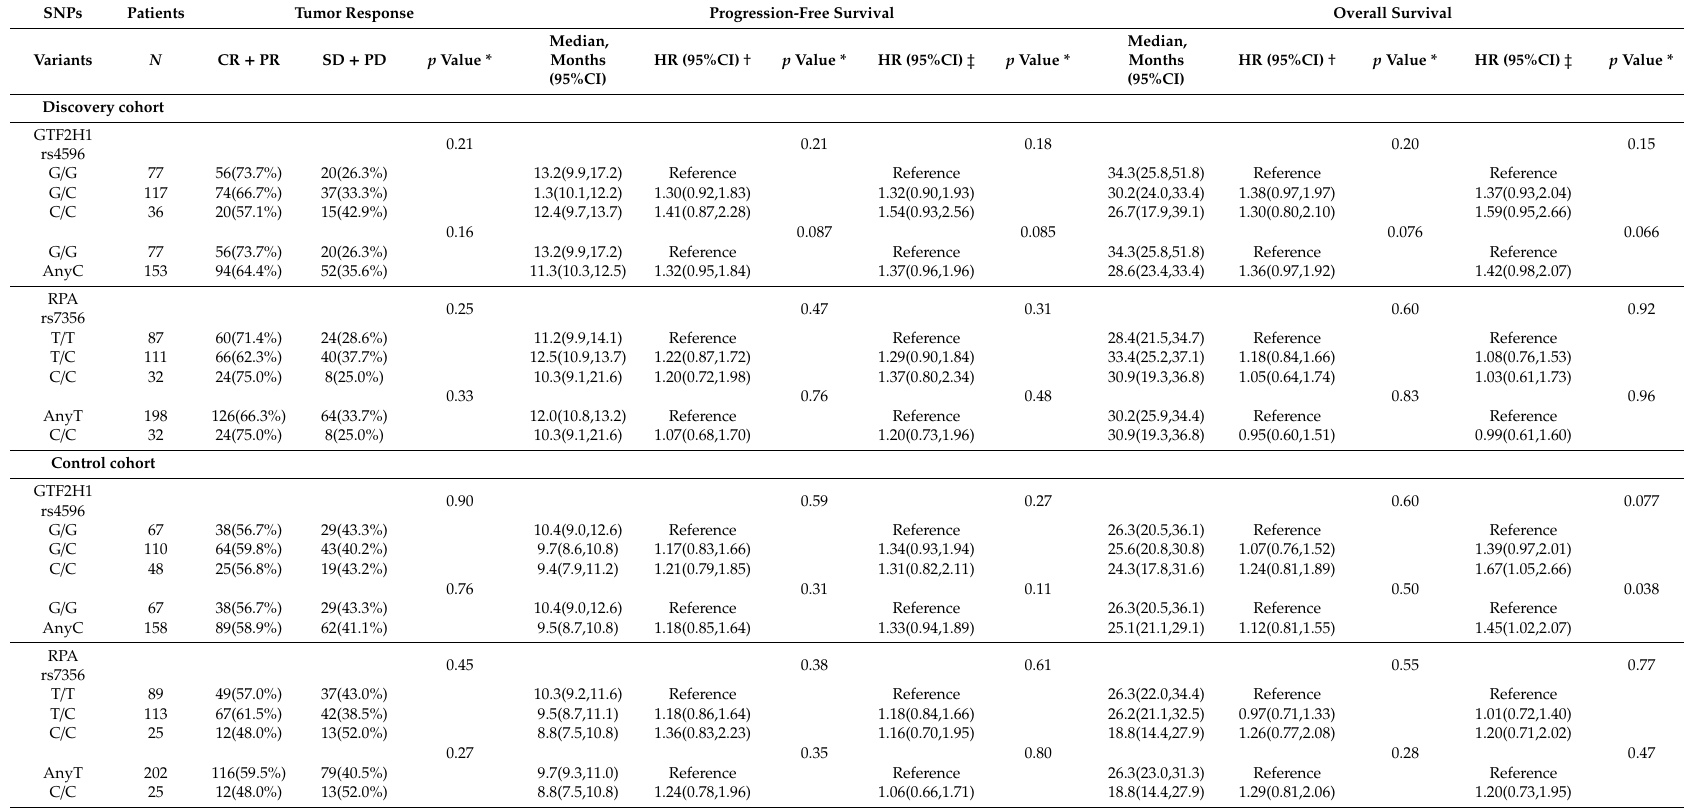
Table 1. Association between gene polymorphism and clinical